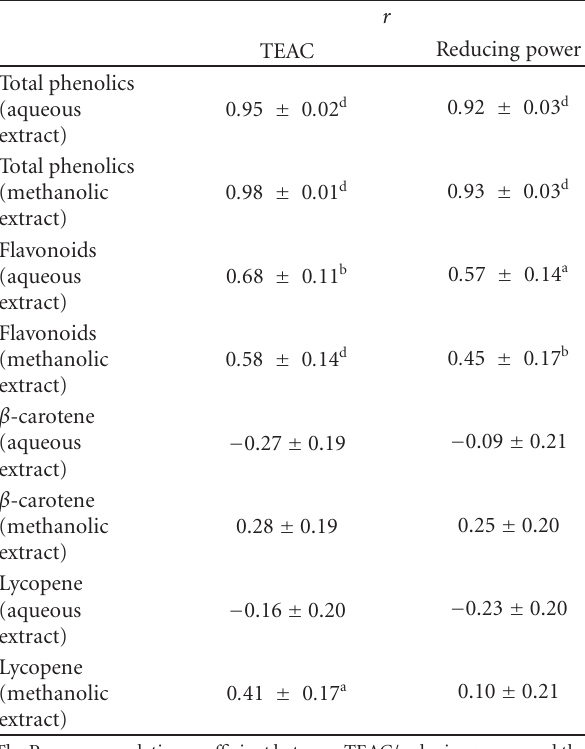
Table 4: The correlation between the concentrations of antioxi- dants and TEAC/reducing power.